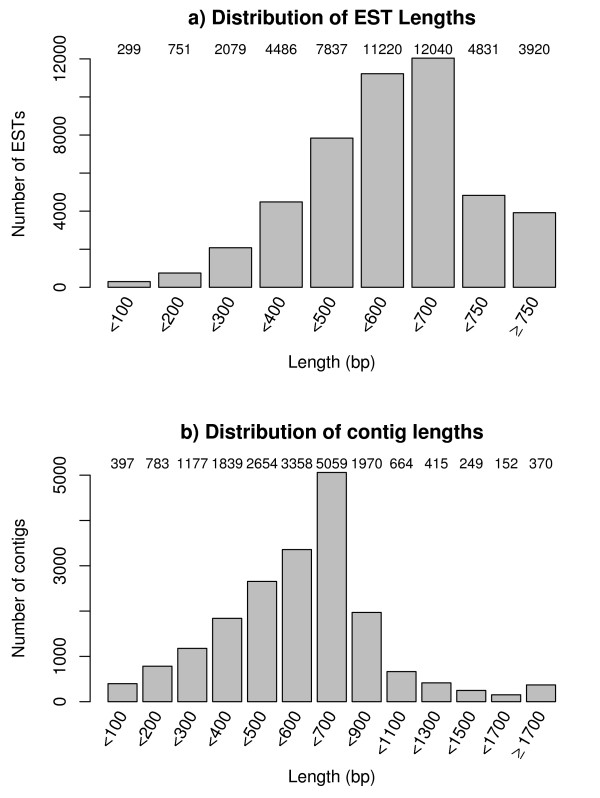
Distribution of sequence length and EST count per contig. a) Distribution of the read length of the ESTs after quality control, b) Distribution of sequence length of the assembled contigs.